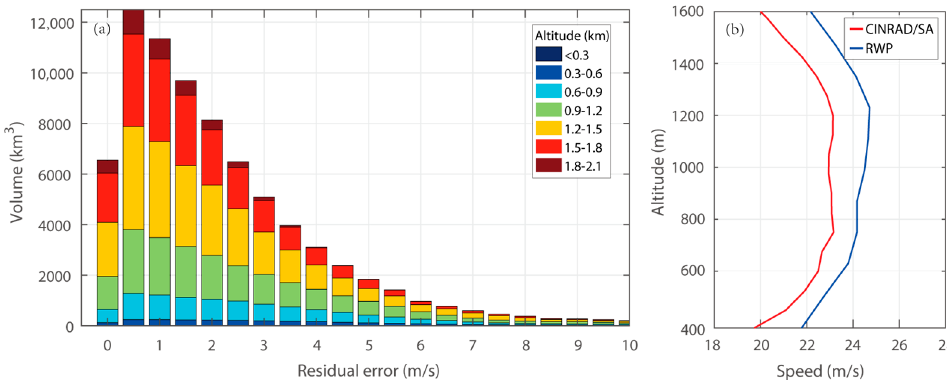
Figure 12. ( a ) Histogram of the residual error of the VAD analysis at di ff erent altitudes. The volume of the radar beam is used to calculate the ordinate. ( b ) The pro fi les of the mean wind speed during 12:30 to 13:30 (UTC) on 2 May 2021.